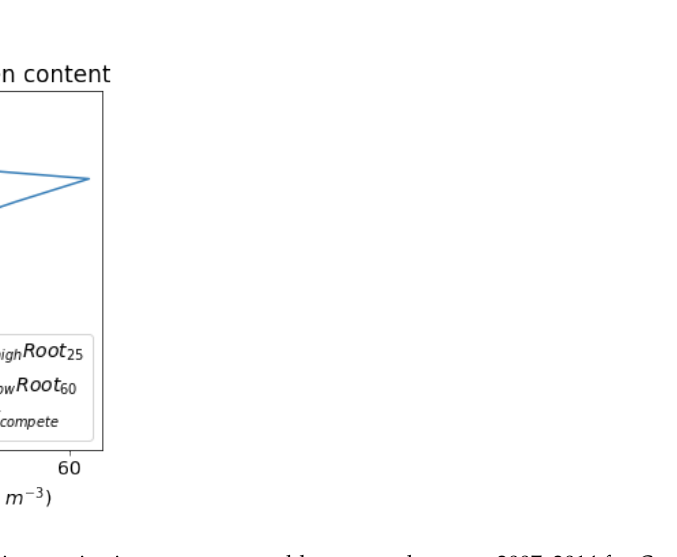
Figure 3. Vertical profile of inorganic nitrogen as a monthly average between 2007–2014 for Control and CN high Root 25 (25 cm rooting depth) and CN low Root 60 (60 cm rooting depth), and PFT compete . The mean maximum summer thaw depth is between 60 and 65 cm.